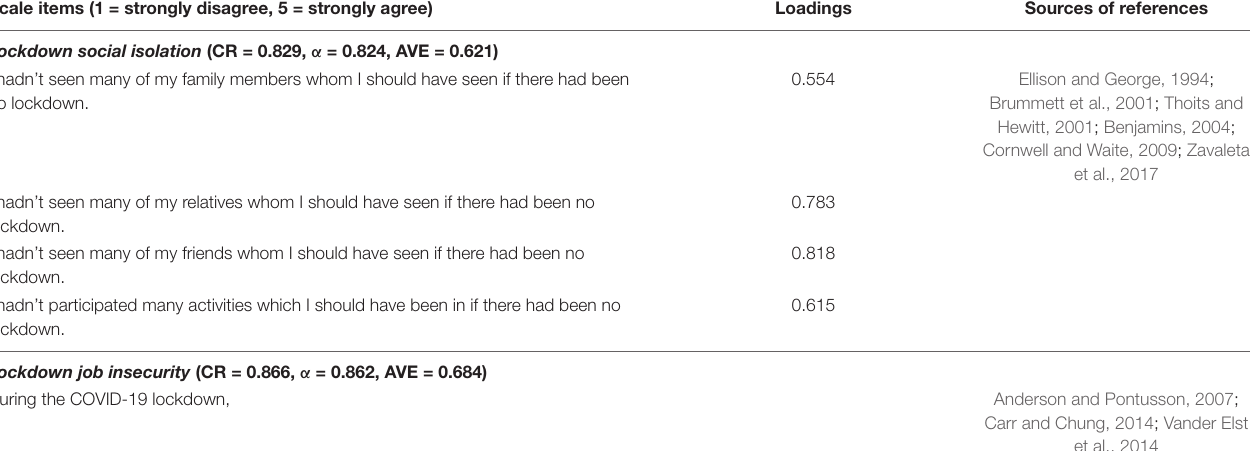
TABLE A1 | Description of measurement